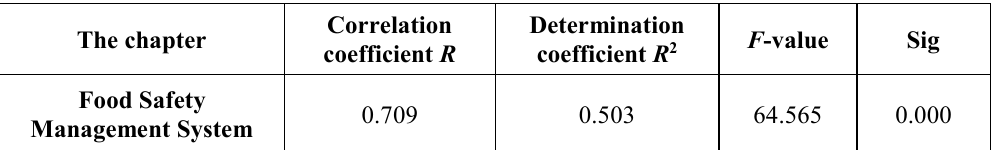
Table 7. Result of Simple Regression Analysis to Test the Impact of Food Safety Management System on Customer Loyalty Correlation Determination The coefficient R coefficient R 2